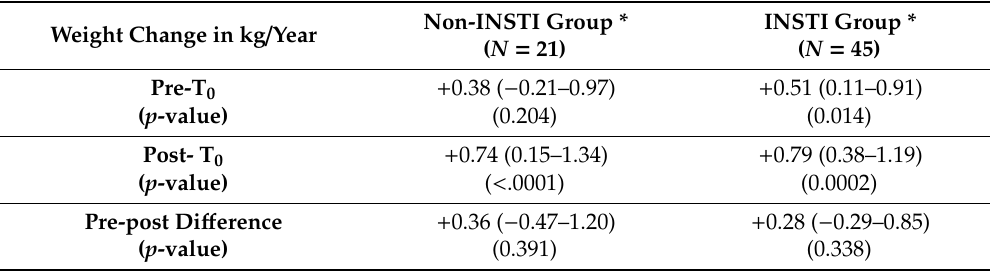
* Adjusted for age, sex and weight at